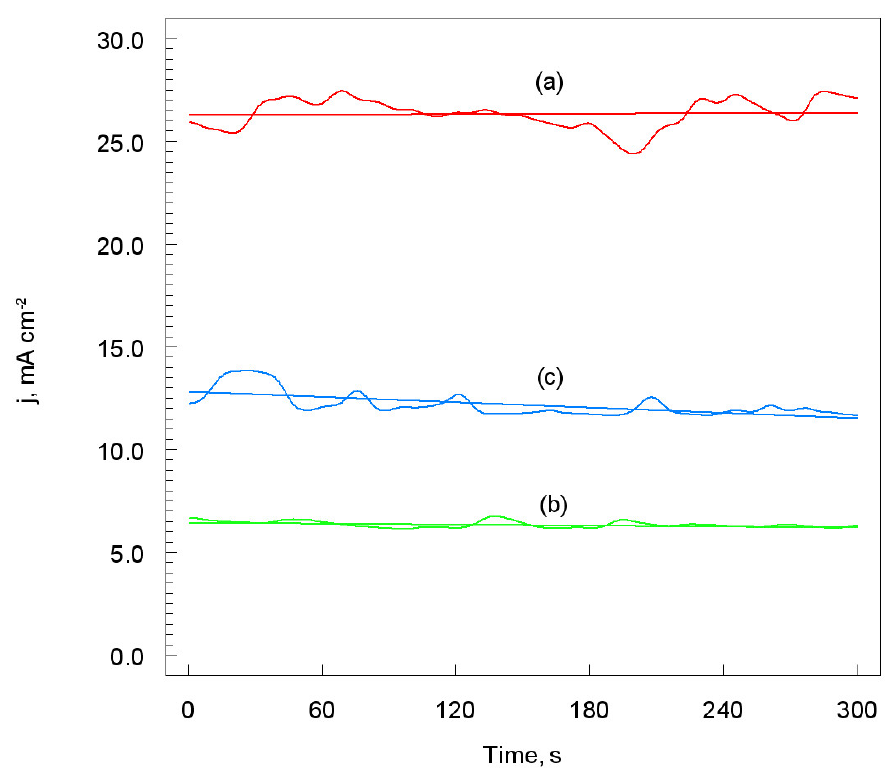
Figure 7. Chronoamperometric curves obtained for − 150 mV of titanium coatings onto Al7075 substrate deposited at SoD of: ( a ) 20 mm, ( b ) 70 mm, and ( c ) 100 mm. Solutions contained 1.2 M Cl − , pH 1.5. (Straight lines refer to the average current density values).